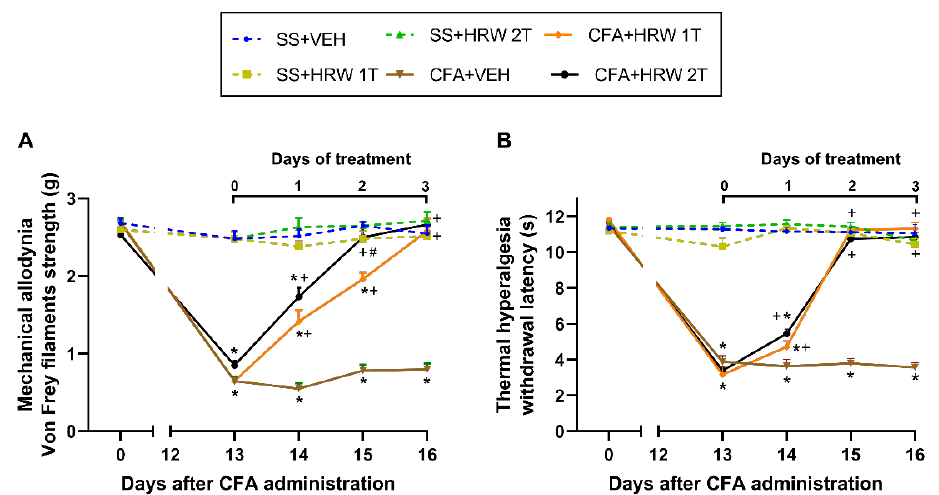
Figure 1. Effects of the intraperitoneal injection of HRW or VEH on the mechanical allodynia and thermal hyperalgesia induced by paw inflammation. Effects of the repetitive administration of HRW or VEH, injected at 1T and 2T per day, over the decreased von Frey filaments strength (g) ( A ) and the withdrawal latency (s) ( B ) generated by CFA in the ipsilateral hind paws. For each test, * indicates significant changes vs. their respective SS-injected mice (SS + VEH, SS + HRW 1T, or SS + HRW 2T), + represents significant differences vs. CFA + VEH injected mice, and # denotes significant differences vs. CFA + HRW 1T ( p < 0.05, on one-way ANOVA and Student–Newman–Keuls test). Data are presented as mean values ± SEM; n = 6 animals for group.